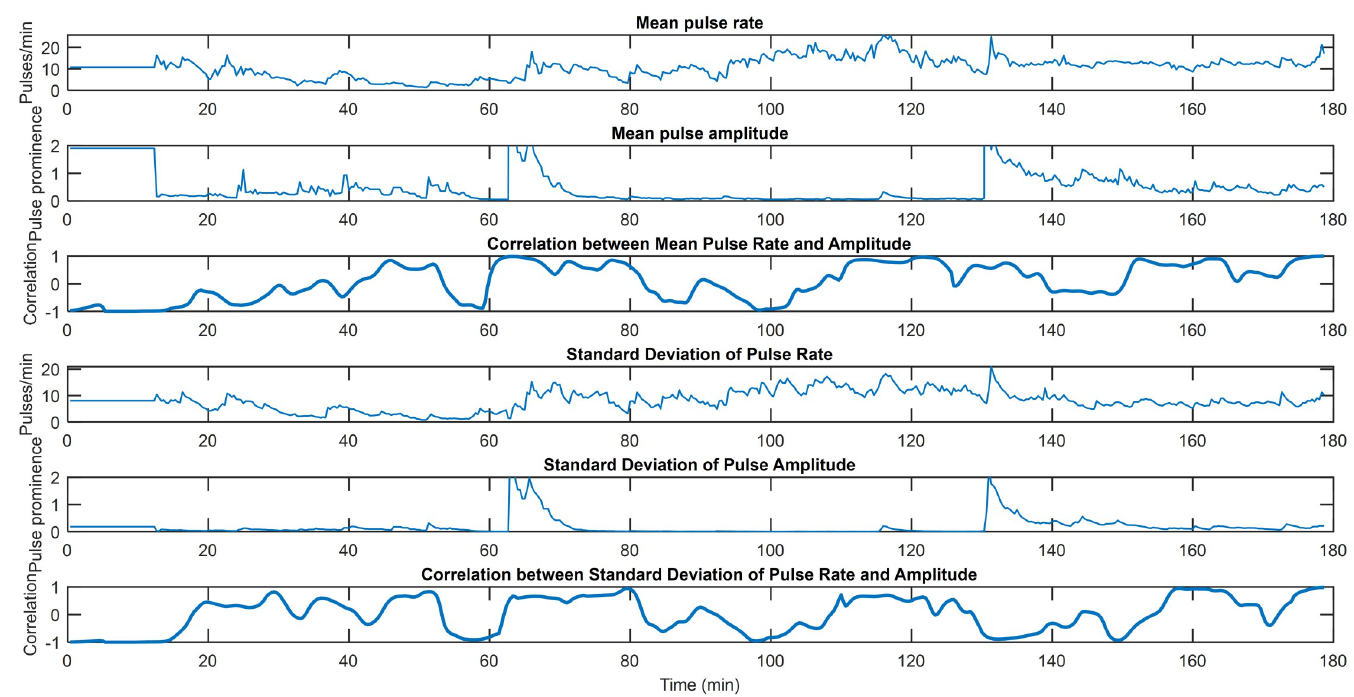
Fig 3. EDA indices from Subject 6. From top to bottom, mean pulse rate, mean pulse amplitude, correlation between mean pulse rate and pulse amplitude, standard deviation of pulse rate, standard deviation of pulse amplitude, and correlation between standard deviations of pulse rate and pulse amplitude. This subject shows both periods of high correlation and high anti-correlation between pulse rate and amplitude information. Specifically, from 60–100 minutes, they go from highly correlated to highly anti-correlated. This reflects a “handoff” of information, going from both rate and amplitude to largely rate alone. In this subject, the rate of pulses is heavily modulated, while most pulses are small except for short periods when pulse amplitude increases